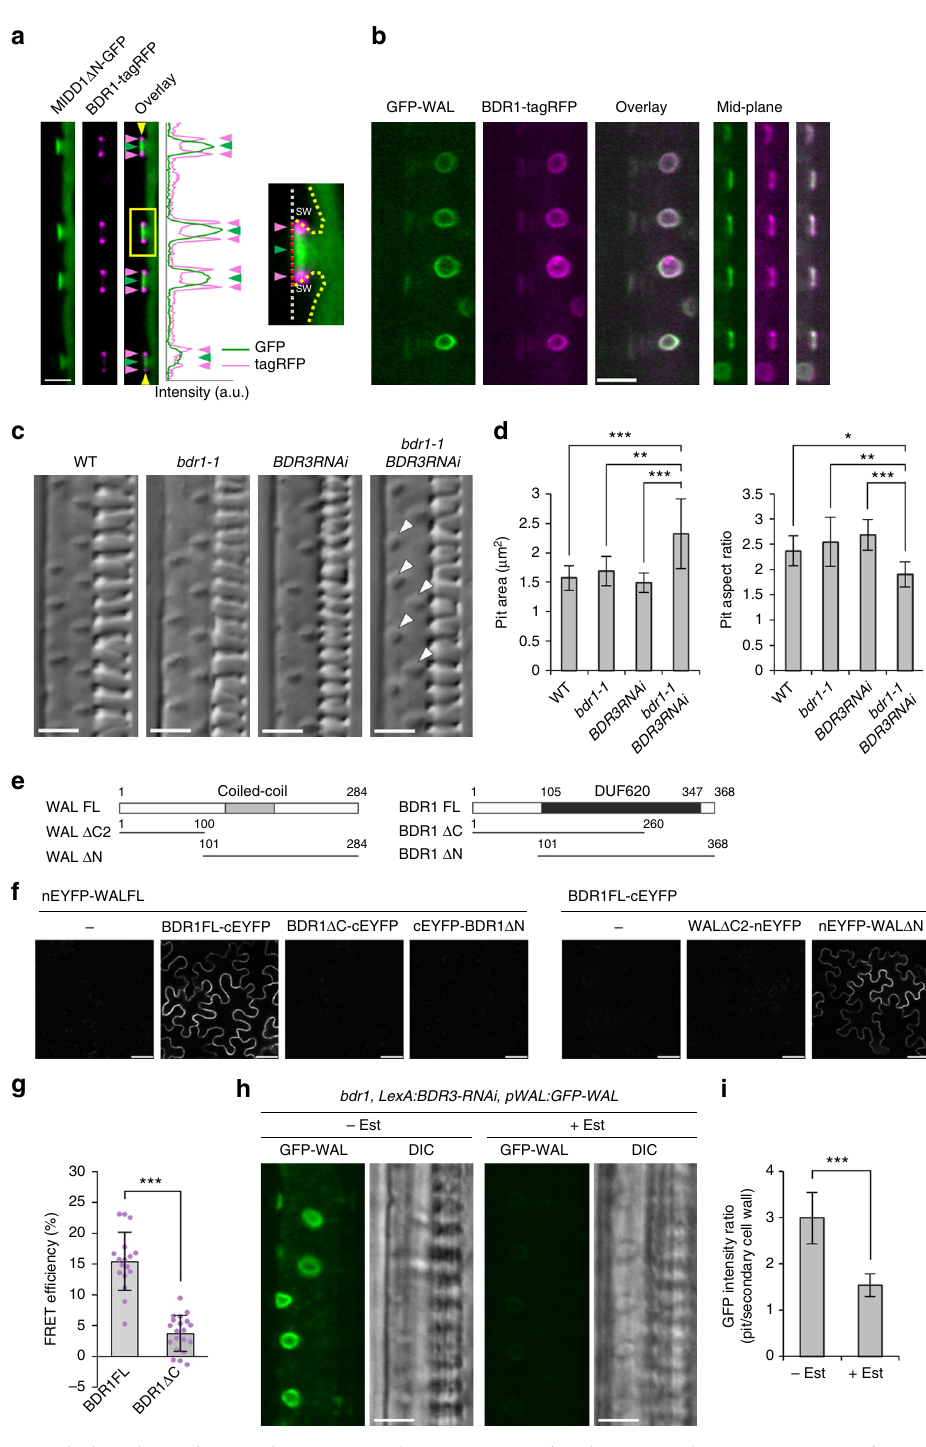
Fig. 3 BDR recruits WAL to the boundaries of pit membranes. a BDR1 ( pBDR1:BDR1-tagRFP ) and MIDD1 Δ N ( pMIDD1:MIDD1 Δ N-GFP ) in metaxylem vessel cells in roots. The mid-plane is shown. BDR1-tagRFP (red arrowheads) localized to the boundary of the MIDD1 Δ N-GFP domain (green arrowheads). The graph shows the intensity pro fi le between the yellow arrowheads. The boxed area is magni fi ed in the right panel. Yellow broken lines indicate edges of secondary cell walls (SW). The red broken line indicates the pit membrane. b WAL ( pWAL:GFP-WAL ) and BDR1 ( pBDR1:BDR1-tagRFP ) in metaxylem vessel cells in roots. Cortex (left) and mid-plane (right) from different cells are shown. c DIC of WT, bdr1-1 , BDR3RNAi , and bdr1-1 BDR3RNAi plants. d Surface area and aspect ratio of secondary cell wall pits. Values are mean±s.d. ( n >250 pits), * p <0.05; ** p <0.01; *** p <0.001 (ANOVA with Scheffe test). e Diagram of full-length and truncated fragments of WAL and BDR1. The black region indicates a DUF620 domain. Numbers indicate the positions of amino acid residues. f BiFC assay between WAL and BDR1 in leaf epidermal cells. BiFC signal was observed when nEYFP-WAL FL or nEYFP-WAL Δ N was co-expressed with BDR1 FL-cEYFP. g FRET ef fi ciency between EYFP-WAL and BDR1-ECFP and between EYFP-WAL and truncated BDR1 Δ C-ECFP. Values are mean±s.d. ( n >15), *** p <0.001 (Student ’ s t -test). h GFP-WAL in metaxylem vessel cells in roots of bdr1-1 BDR3RNAi plants treated with ( + Est) or without ( − Est) 2 μ M estradiol. i Intensity ratio of GFP-WAL (inside of pit/outside of pit). Values are mean±s.d. ( n >30), *** p <0.001 (Student ’ s t -test). Bars = 50 µ m ( f ) and 5 µ m ( a – c and h ). Source data are provided as a Source Data fi